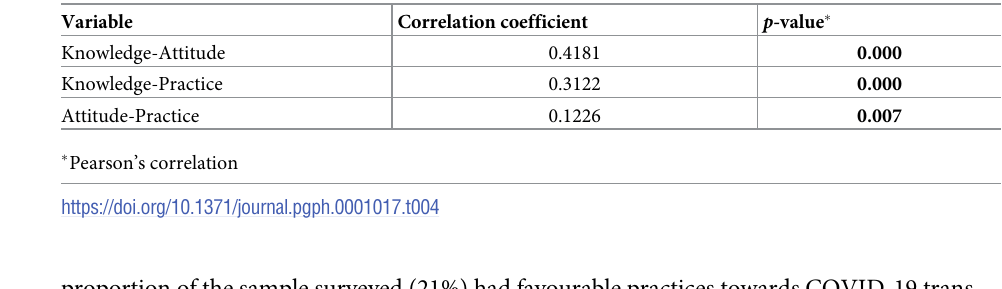
Table 4. Correlation between knowledge, attitude, and practice